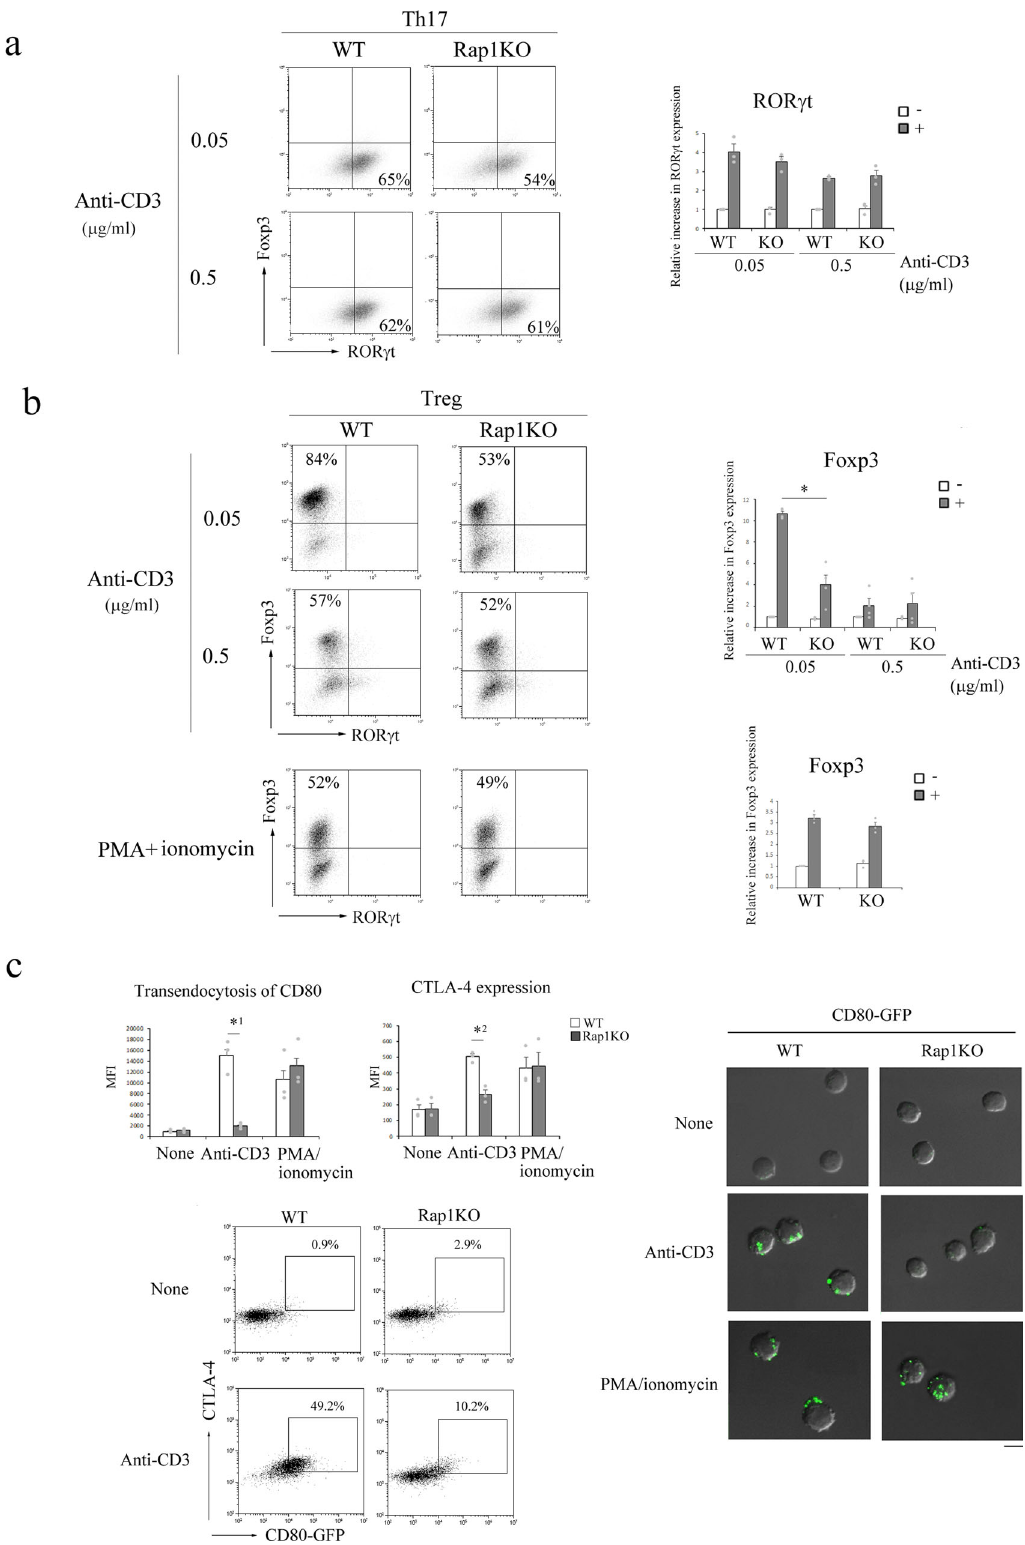
low concentration of anti-CD3 in the presence of anti-CD28 than WT naïve CD4 + cells. T cells have been reported to reorganize the actin cytoskeleton in response to TCR engagement, which is indispensable for TCR-mediated signaling 43 . Three discrete actin networks, namely the lamellipodial branched-actin network, the